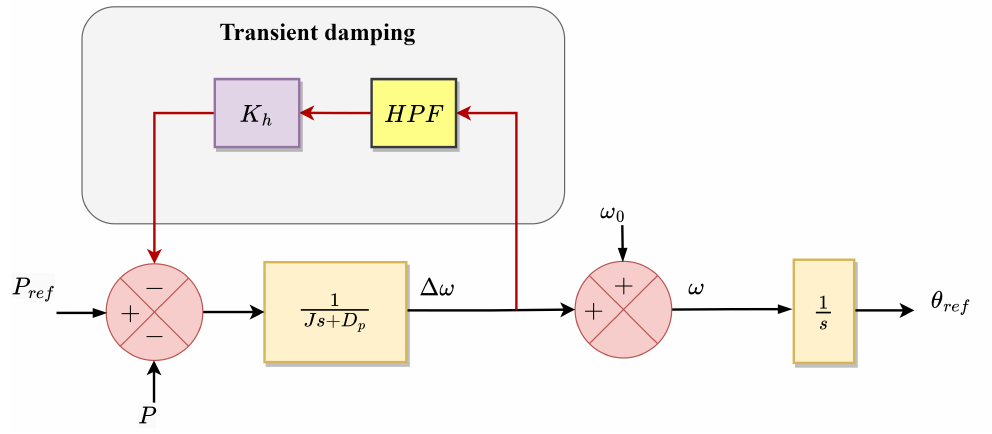
Figure 23. Proposed TDM through HPF